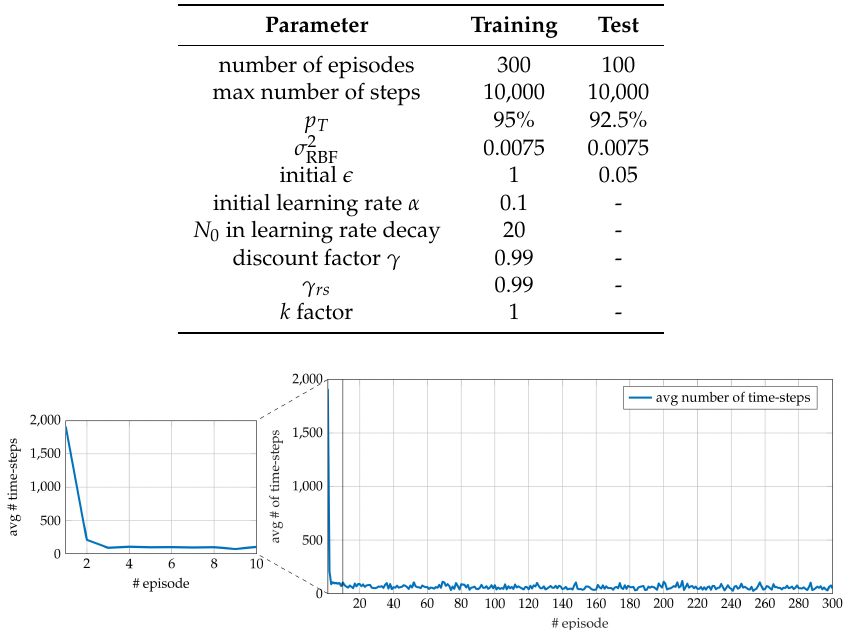
Figure 3. Average number of time-steps for each episode during the 10 runs in training performed on the EOS system. The average number of time-steps required in the first 10 episodes is highlighted in the enlarged portion.